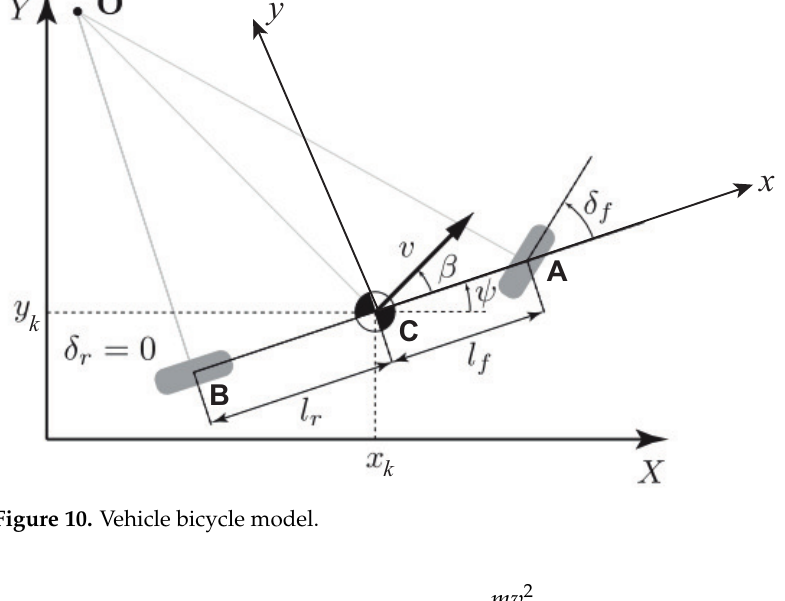
Figure 10. Vehicle bicycle